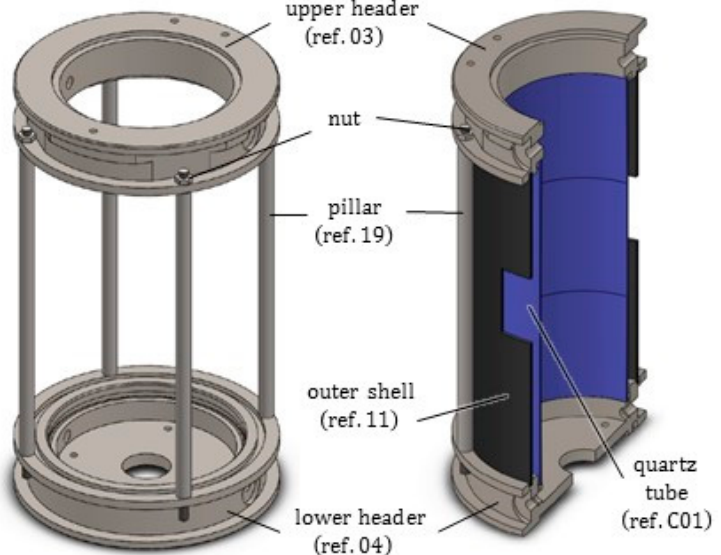
Figure 4. Upper and lower header of the furnace, fastened by four pillars (ref. 19). The outer metal shell (marked by black color) and the quartz glass tube (in blue) rest inside the grooves of the two headers. In both the headers, the lateral ducts for the inert gas can be recognized.